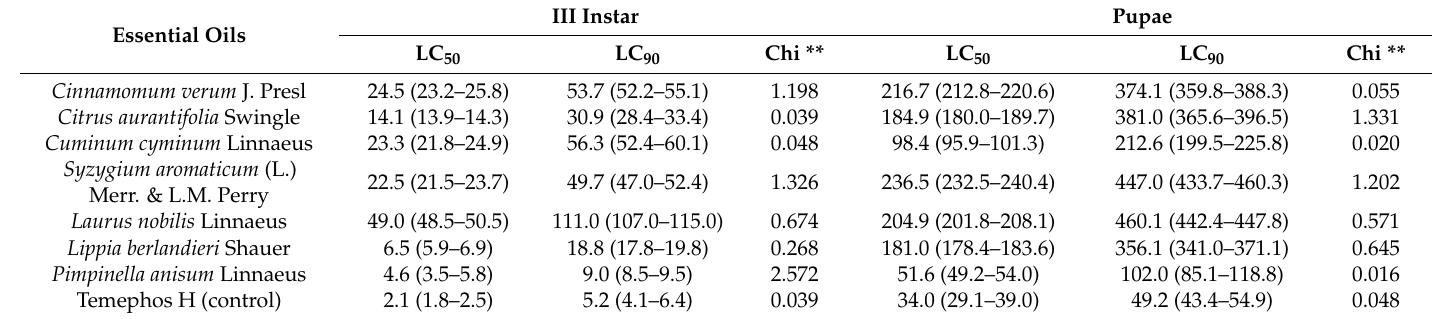
Table 2. LC 50 and LC 90 ( µ g/mL) of essential oils on Culex quinquefasciatus at III instar and pupal stages after 24 h of exposure.